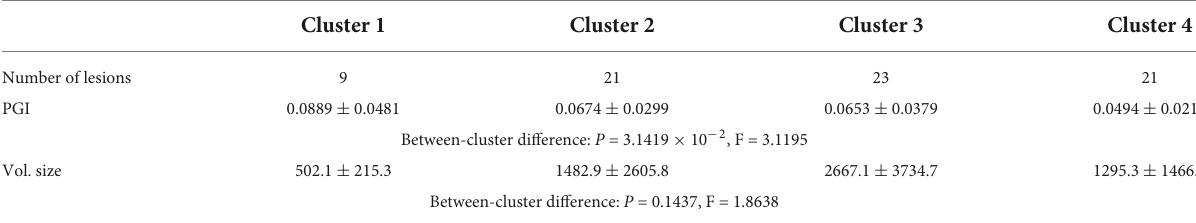
TABLE 2 ANOVA analysis of the potential growth indices (PGIs) for shape clusters and corresponding lesion sizes in the S l group. SHAPE (volume size > 250